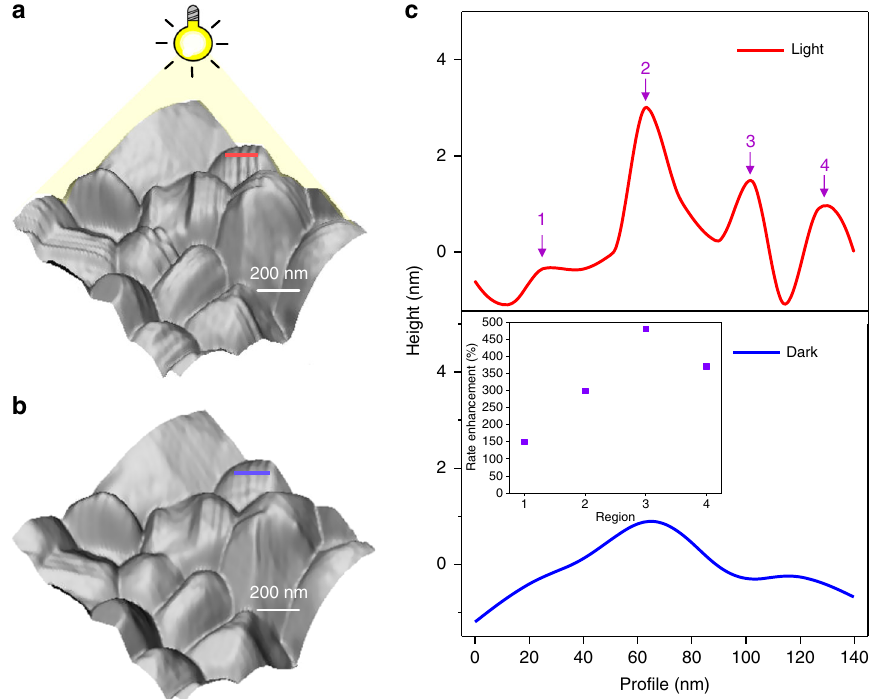
Fig. 2 Light-induced structural surface variation of MA-FA perovskite. 3D topography a with light, b without light, and c corresponding line pro fi les for topography in under light (red) and in the dark (blue). The inset represents rate enhancement at the marked